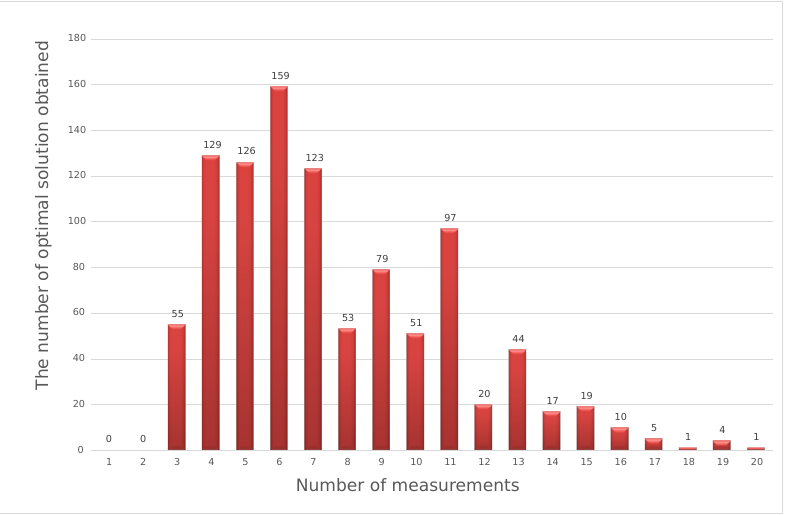
Figure 6. Optimal solutions in the min–max method for a simulated series of 1000 input data